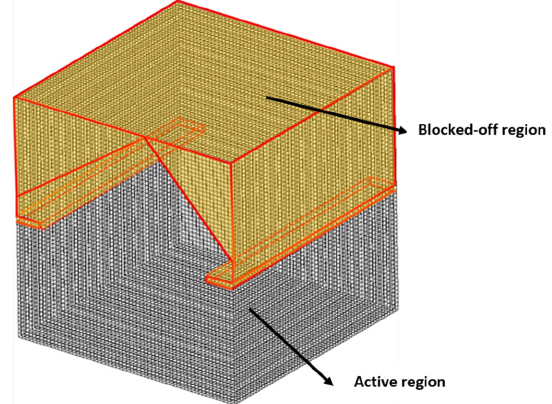
Figure 2. Blocked-off region in a regular